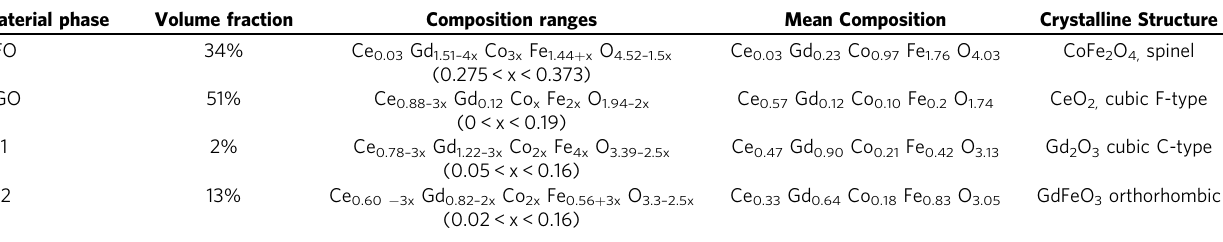
The volume fraction of each phase is determined by the segmentation of the volumetric tomography dataset. The quintenary compositions de fi ned in the text (Ce w Gd x Co y Fe z with w + x + y + z = 1) are converted into the conventional bulk compositions based on the crystalline structure of these material phases. The mean composition is taken at the middle of the composition range. The oxygen stoichiometry is estimated by assuming the oxidation states: Ce = 4, Gd = 3, Fe = 3, and Co =